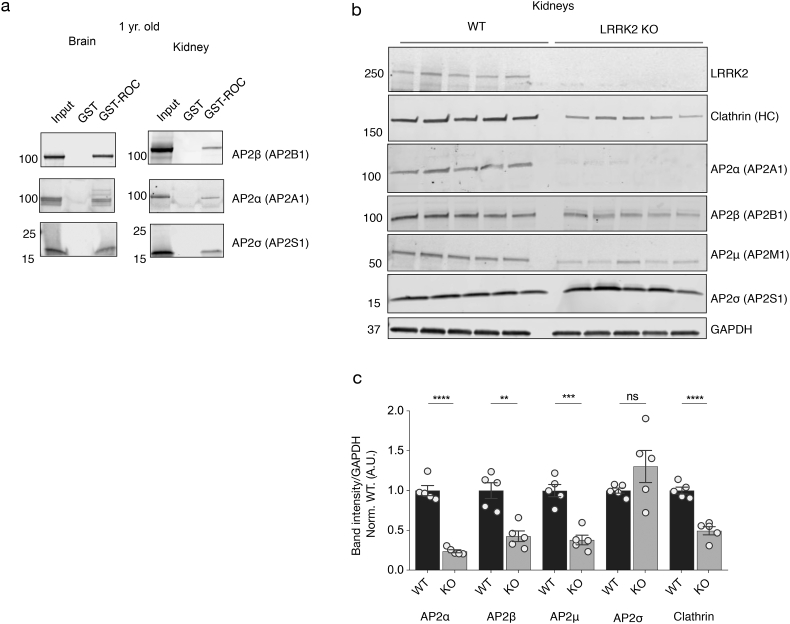
ROC binds to the AP2 complex in brain and kidney and is dysregulated in LRRK2 KO animals. (a) Validation of candidate hits by pull down assays with purified GST or GST-ROC protein from brain and kidney lysates. All organs were taken from 1 year old WT C57Bl6 mice. Western blots demonstrate binding of heavy and small subunits to the LRRK2 ROC domain in both tissues. Data is representative of n = 3 independent experiments with similar results performed in both tissues. (b) Deregulation of AP2 in vivo. Protein extracts from one yr. old WT or LRRK2 knockout kidneys were used for immunoblotting for the indicated proteins. Markers on the left of all blots are in kilodaltons. (c) Quantification of protein levels. All values are normalised to GAPDH as a loading control and expressed relative to the mean of wild type animals. (n = 5 animals; * P < .05, ** P < .01, Student's t-test with Welch's correction for unequal variance).